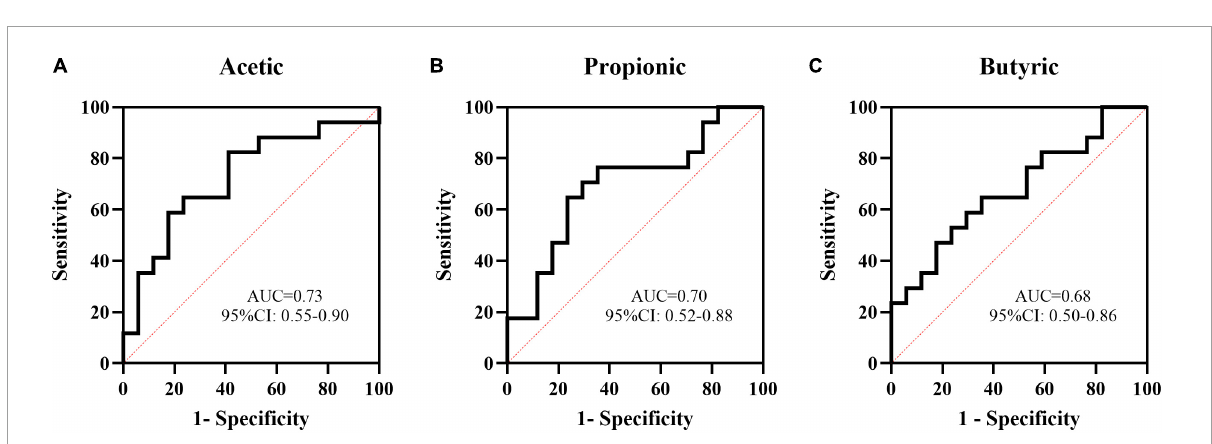
FIGURE5 The value of some short-chain fatty acids (SCFAs) in the prediction of NEC by ROC curve analysis. The AUCs of acetic (A) , propanoic (B), and butyric (C) acids between Groups C and P were 0.73, 0.70, and 0.68,